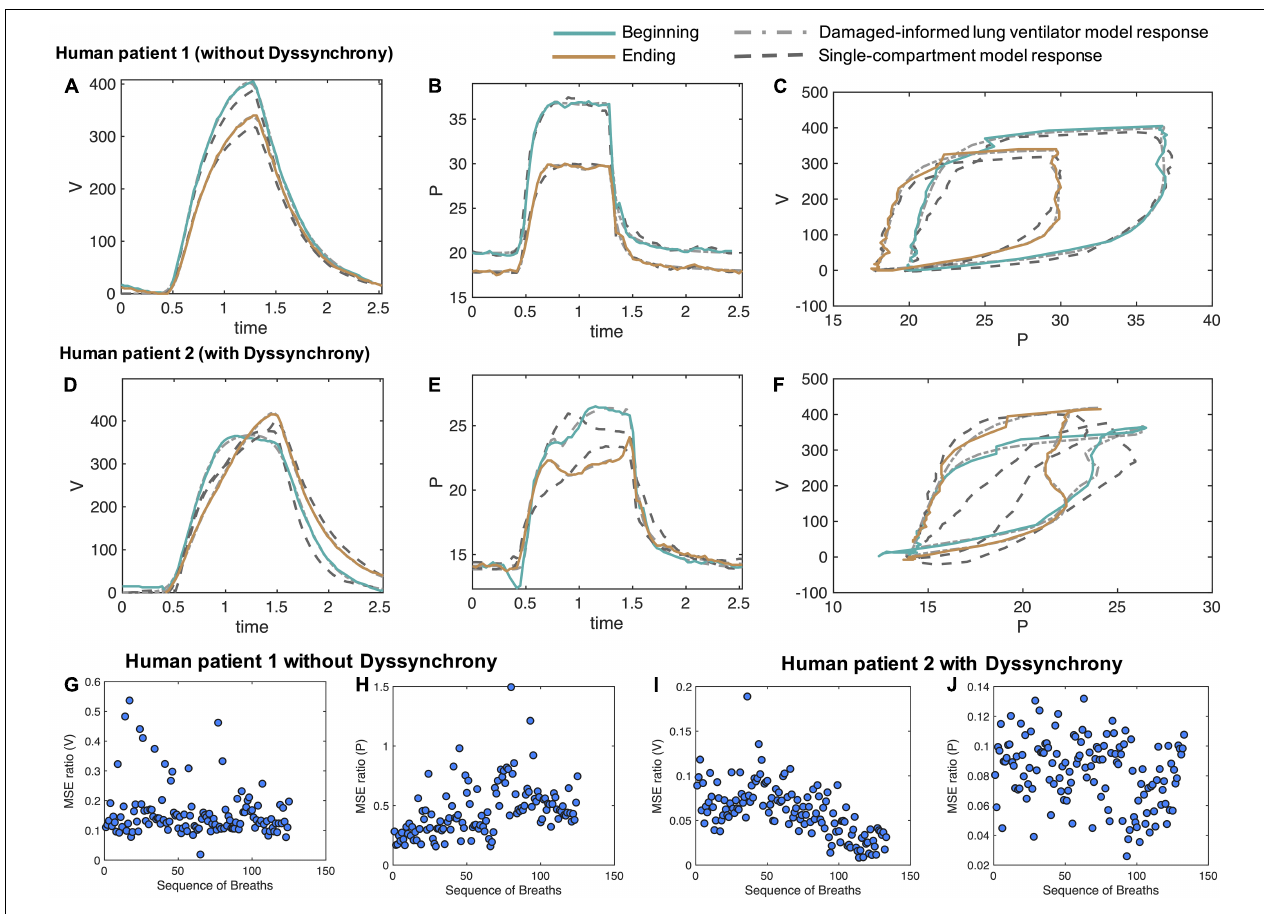
FIGURE 6 | Damaged-informed lung ventilator model can accurately follow breaths of the ICU patients with ARDS without and with dyssynchrony. Measured representative breaths of (A–C) patient 1 without dyssynchrony and (D–F) patient 2 with flow limited dyssynchrony are shown in solid lines, while the DILV model inferred response is shown in the dashed-dot lines. The response of the single-compartment model is shown in dashed-dashed lines. Histograms of the initial guesses and estimated parameters are shown in the Supplementary Figure 8A . For all the breaths in each case, the corresponding ratio of mean squares errors (MSE) between the DILV model and the single-compartment model is shown in panels (G–J) , respectively, while histograms are shown in Supplementary Figures 9, 10 . The response of the DILV model was determined using Eqs 1–18 to generate the best-fit model response using estimated mean parameter values shown in Table 1 and Supplementary Table 1 . All the data shown here were collected in human-triggered mode (see “Materials and